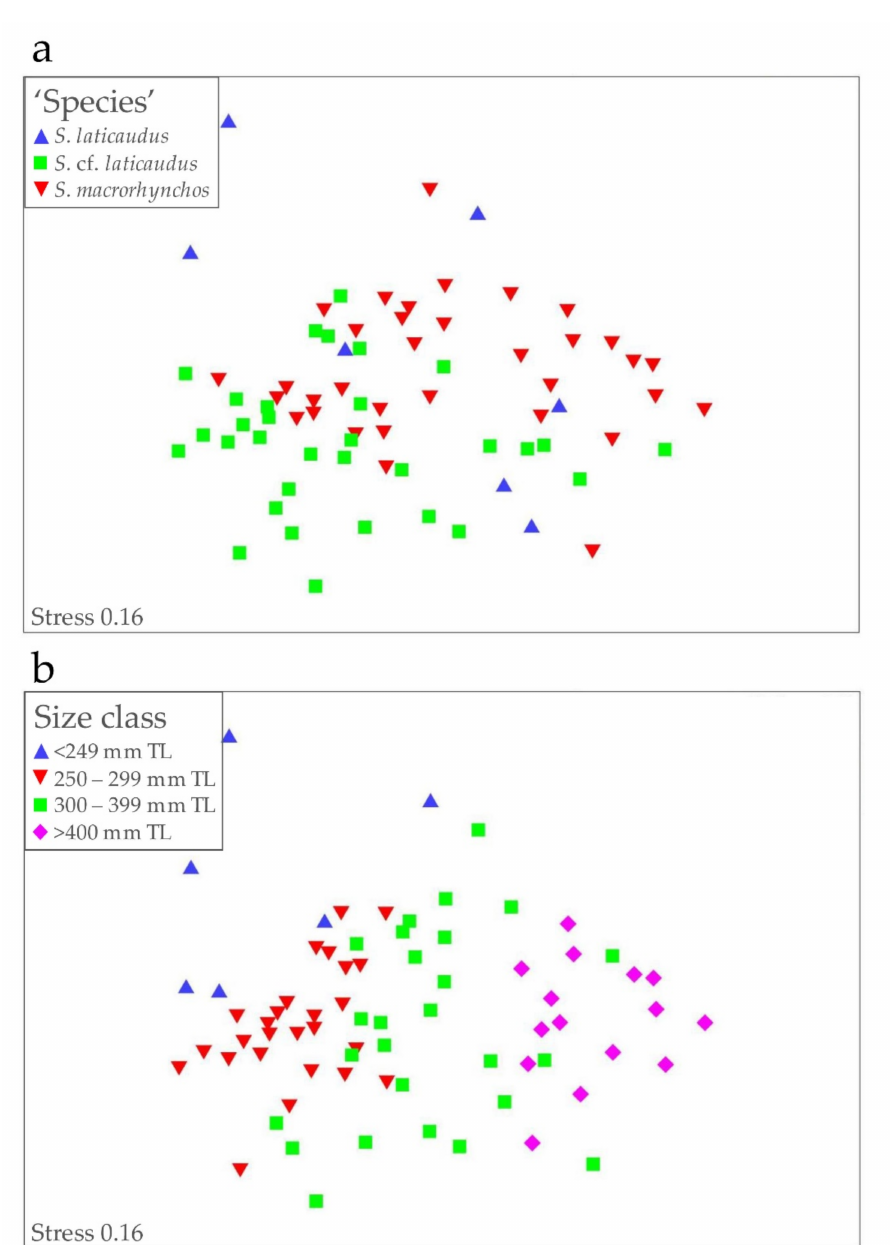
Figure 5. Nonmetric multidimensional scaling (MDS) ordination of Scoliodon ‘species’ morphometric percentages (% TL): ( a ) coded by species and ( b ) coded by size